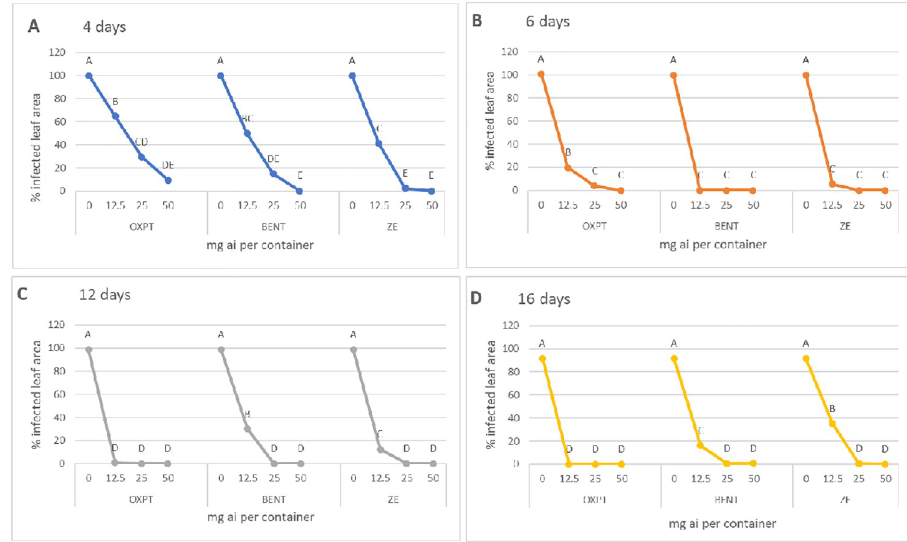
Fig 5. Systemic protection of potato Sifra against late blight by each of three fungicides applied to the soil. Five 8-weeks old potato plants growing a 64 L container were treated with a single soil-drench of 1L fungicide suspension containing 0, 12.5, 25 or 50 mg ai of a fungicide. Leaves (one compound leaf per plant) were detached at 4–16 days after treatment, inoculated with Phytophthora infestans in growth chambers and visually assessed for late blight development at 7 days post inoculation. Different letters on the curves indicate on a significant difference between means (n = 3) at α = 0.05.